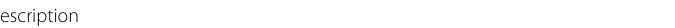
Table 1 Description of the data set Variable Unit